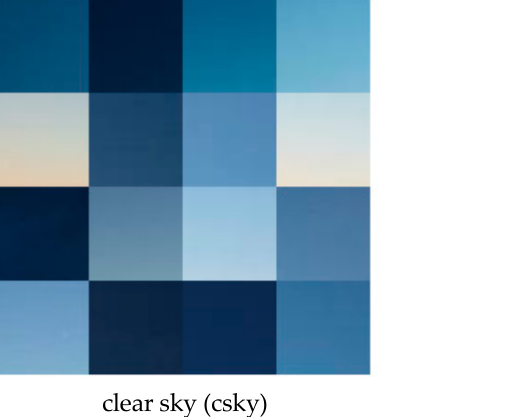
Figure 5. Samples randomly selected from the four categories.